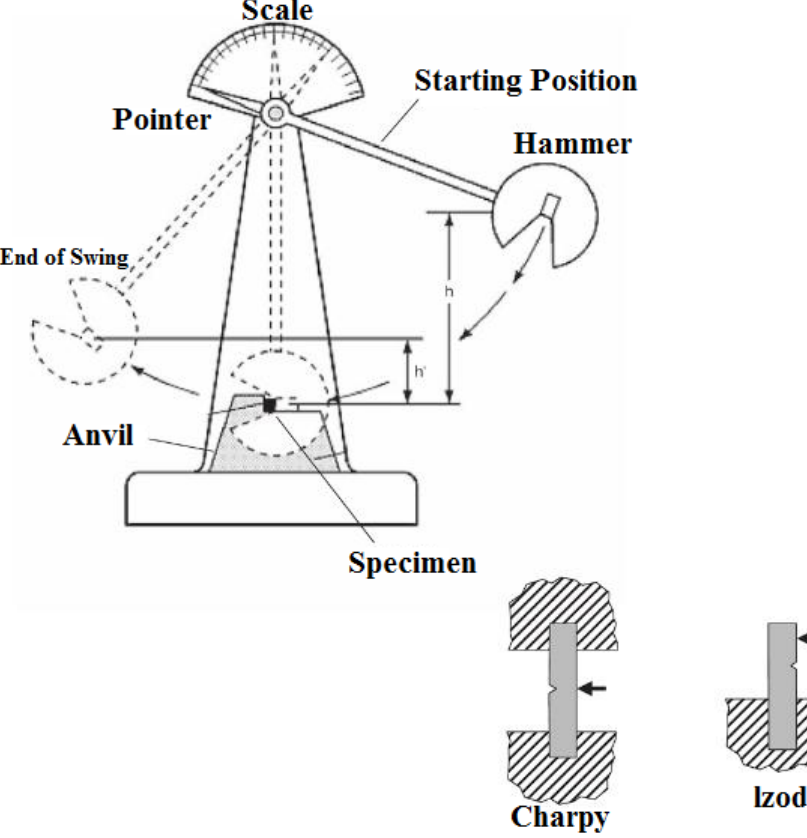
Figure 3. Charpy-Impact Test arrangement and sample design. Reproduced with permission from [3], Springer,